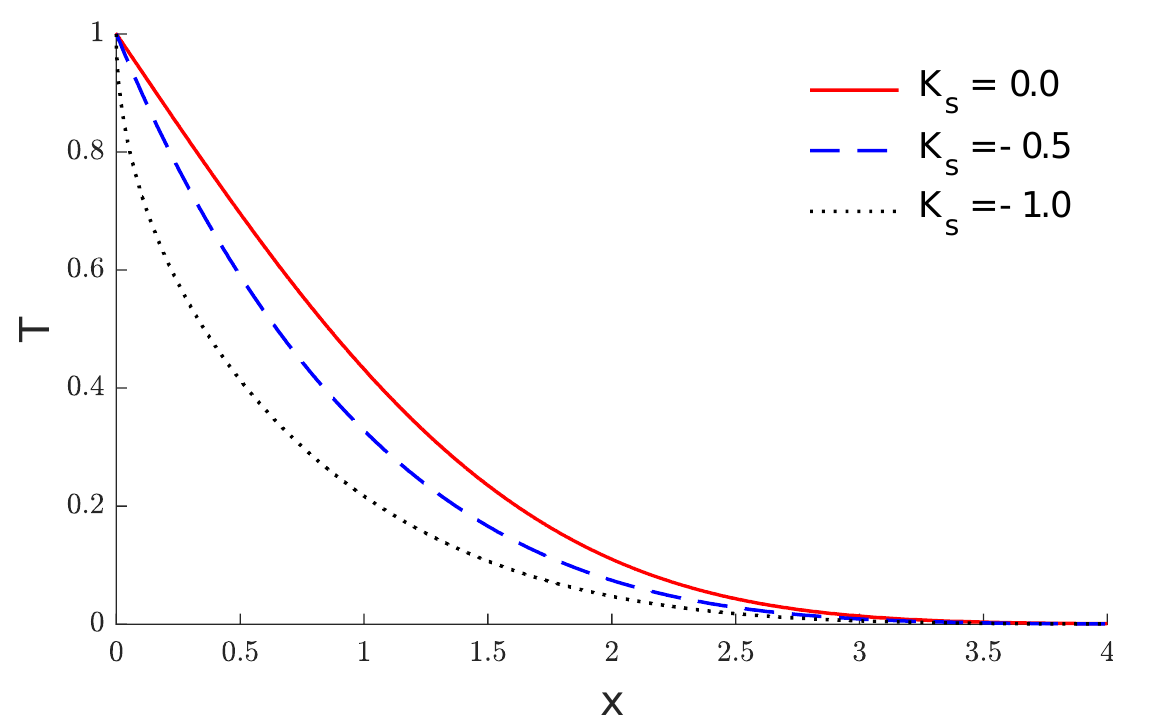
Figure 1. The variation of temperature under various values of 𝐾 𝑠 .